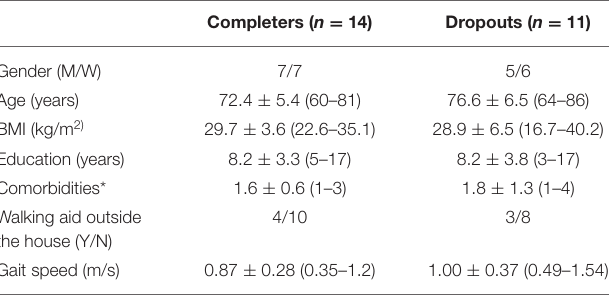
TABLE 1 | Characteristics of the participants [mean ± SD (min–max)] by